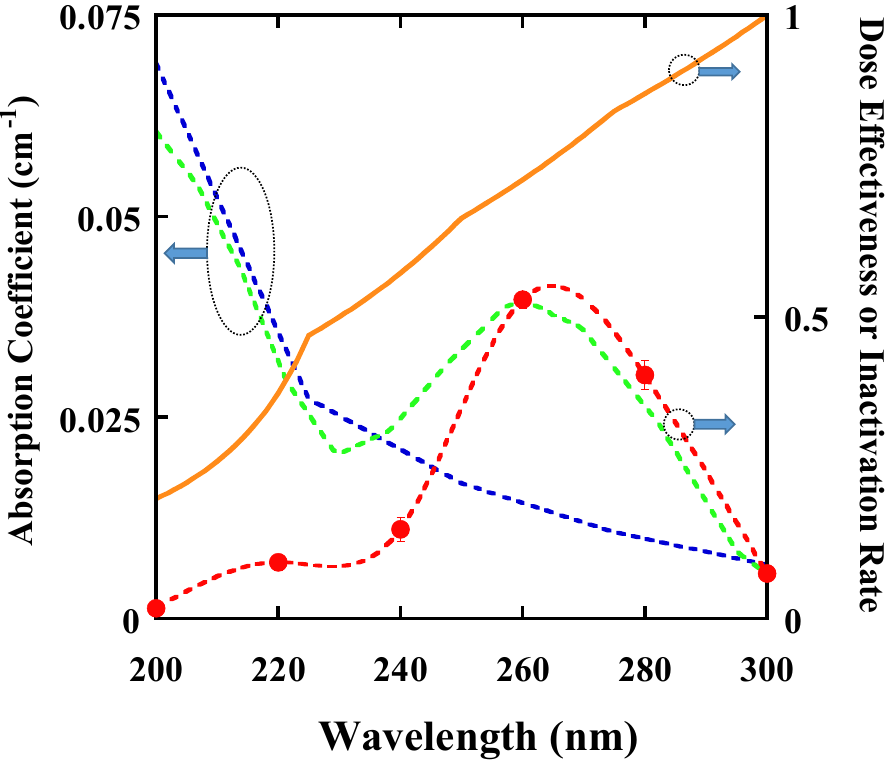
Figure 7. Inactivation rate constants modified by the absorption of water in the DUV wavelength region. The broken blue line shows the absorption spectrum of water. The broken green line shows the absorption spectrum of DNA. The orange line shows the dispersion curve of the effectiveness of the dose obtained by Equation (1), where a 1 m optical path length in water is considered for the calculation. The red circles signify the modified inactivation rate constants due to the absorption of water. The broken red line shows the interpolation curve of these results.